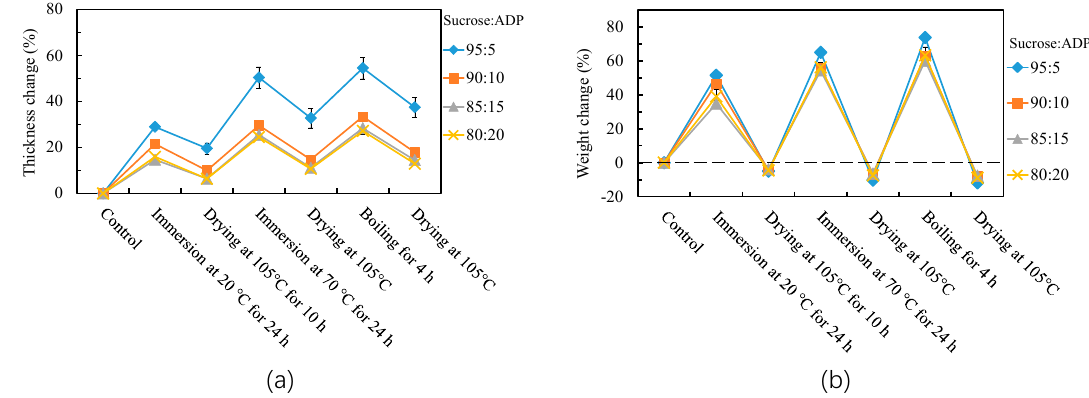
Figure 2. Thickness change ( a ) and weight change ( b ) during cyclic aging treatment of the particleboards bonded with SADP adhesives with different proportions. Error bars indicate the standard deviations.